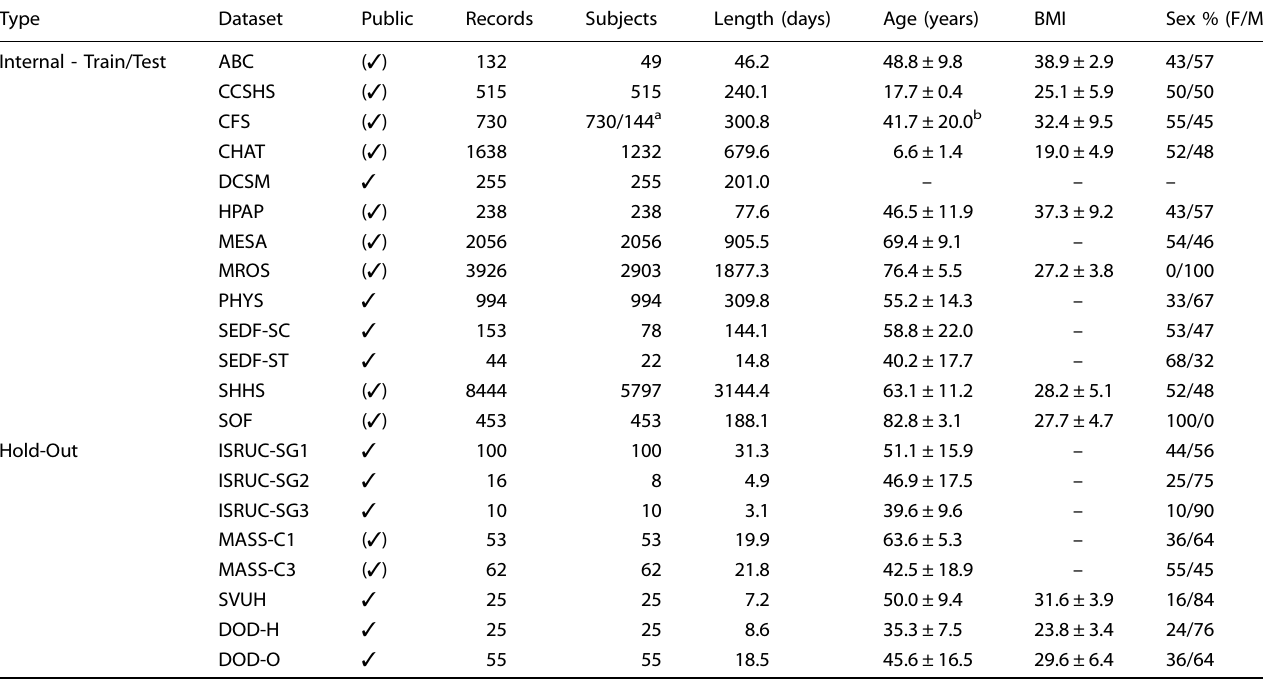
Table 1. Datasets